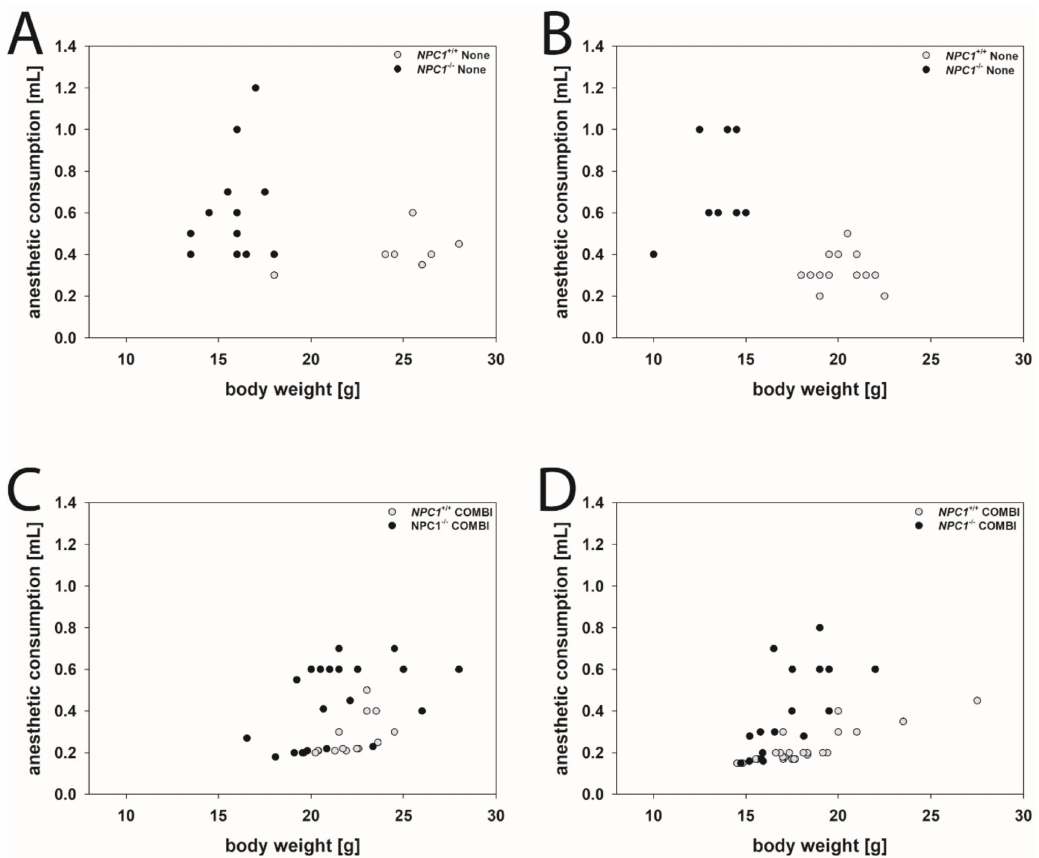
Figure 2. Scatter plots of anesthetic consumption compared to the body weight of None-treated males ( A ) and females ( B ) and COMBI-treated male ( C ) and female ( D ) NPC1 mice. Open dots indicate NPC1 +/+ mice, filled dots indicate NPC1 − / −